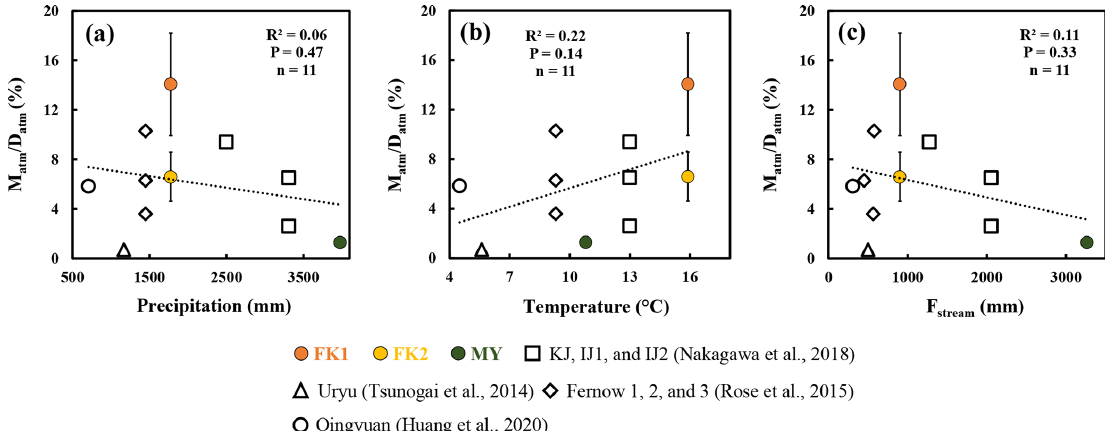
Figure 4. The M atm /D atm ratio plotted as a function of the amount of precipitation (a) , the M atm /D atm ratio plotted as a function of the temperature (b) , and the M atm /D atm ratio plotted as a function of flux of stream water (c) (FK1: orange circles; FK2: yellow circles; MY: green circles). Those determined for the forested catchments in past studies are plotted as well.